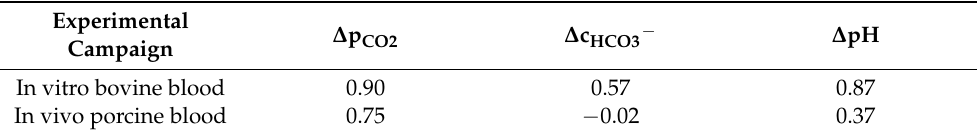
Table 4. Spearman correlation coefficients between CO 2 removal rate and selected process parameters calculated for in vitro bovine and in vivo porcine blood